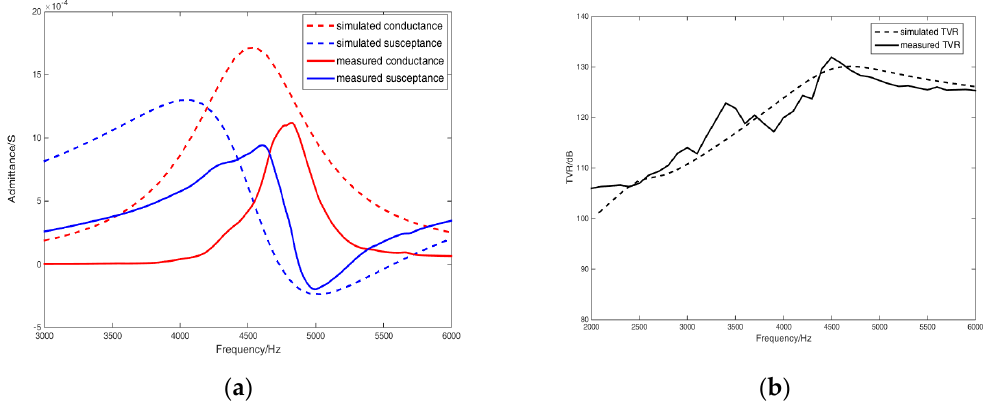
Figure 3. ( a ) The simulated and measured admittance results of the transducer. The solid red and blue line, respectively, represent the measured conductance and susceptance. The dotted red and blue line, respectively, represent the simulated conductance and susceptance. ( b ) The simulated and measured transmitting voltage response of the transducer. The solid and dotted line are the measured and simulated results, respectively.